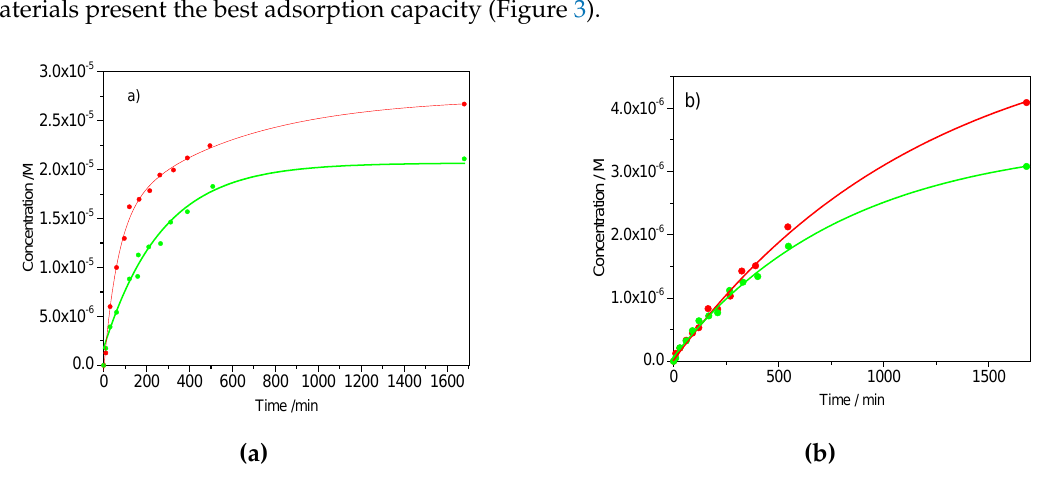
Figure 3. Release kinetics of ( a ) DA and ( b ) AA from the PAAm ( ● ) and NanoC ( ● ).